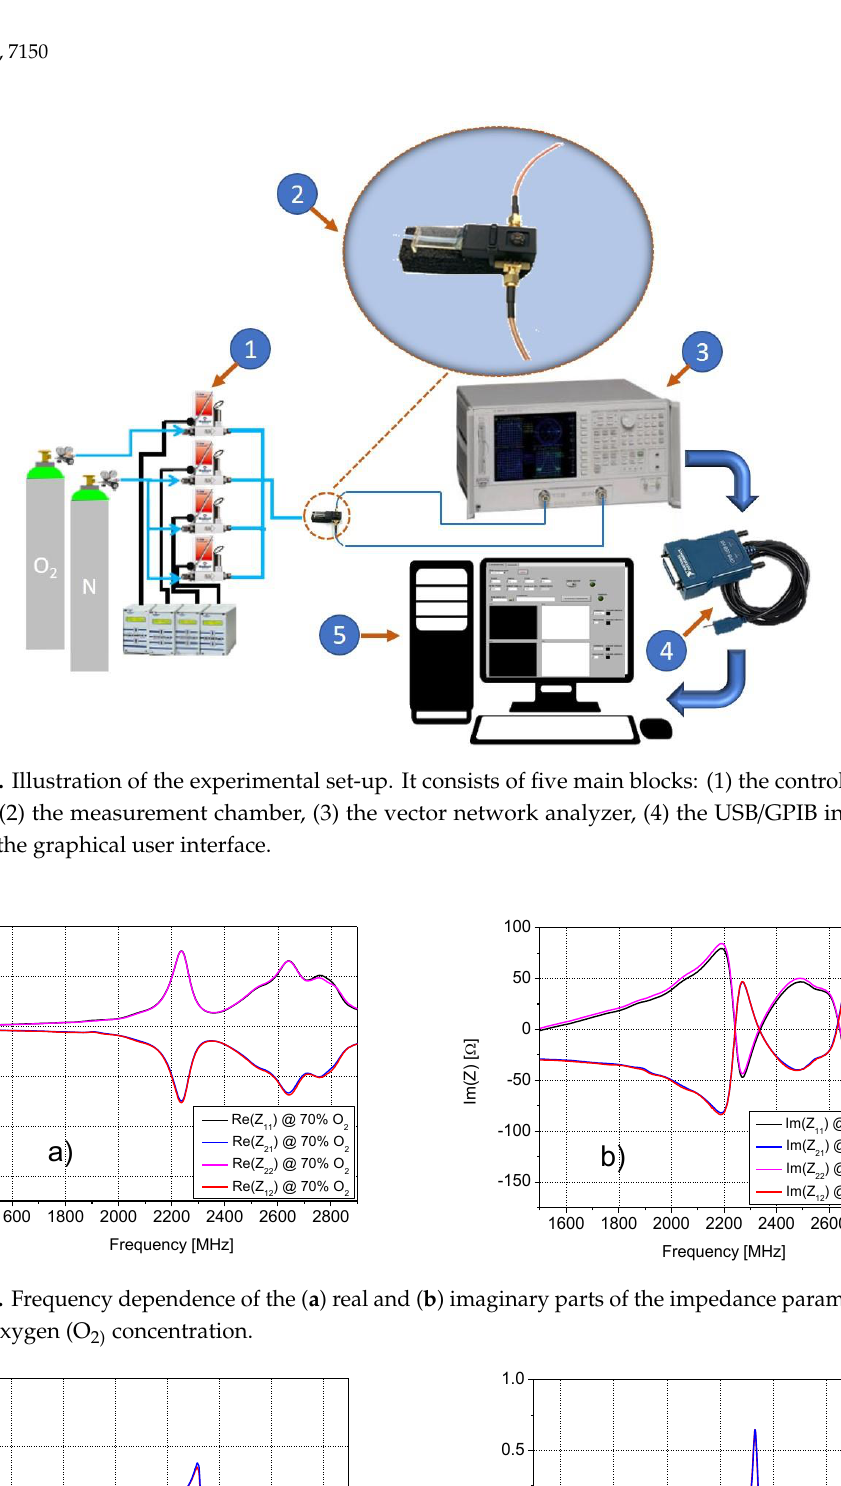
Figure 5. Frequency dependence of the ( a ) real and ( b ) imaginary parts of the impedance parameters at 70% of oxygen (O 2) concentration.